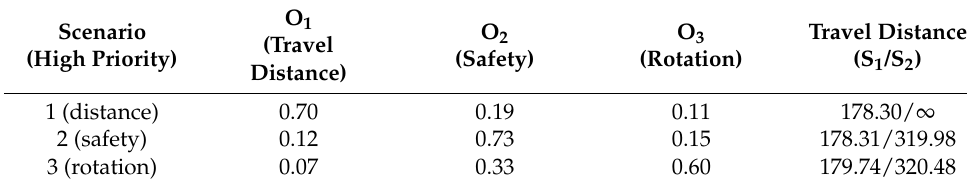
Figure 5. AHP-based path planning. Table 1. Weighting for each objective for AHP-based path planning and results.